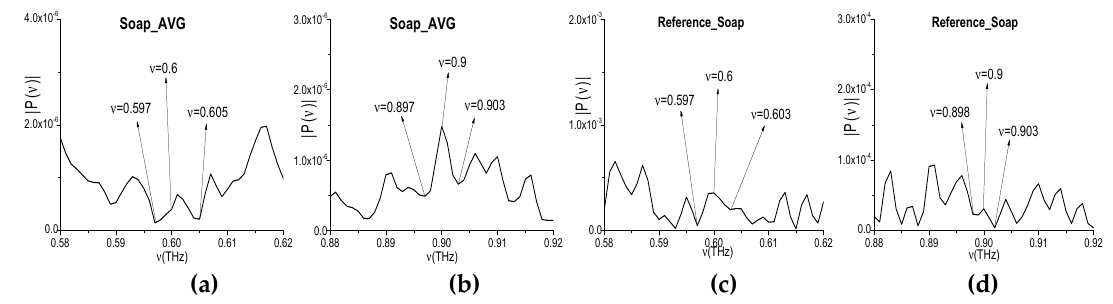
Figure 15. Soap_AVG spectrum (a,b) and reference spectrum (c,d) in the frequency ranges ν = [0.58, 0.62] THz (a,c) and ν = [0.88, 0.92] THz (b,d).